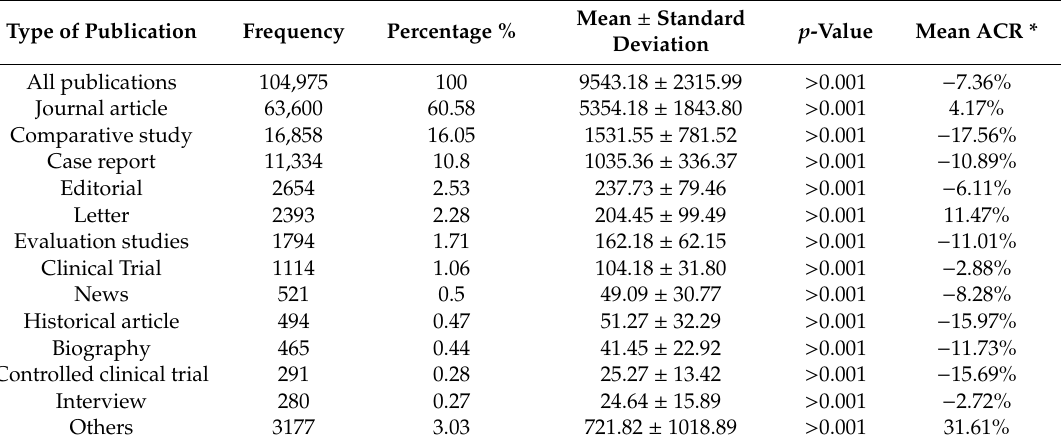
Table 2. Global Dental Publications,